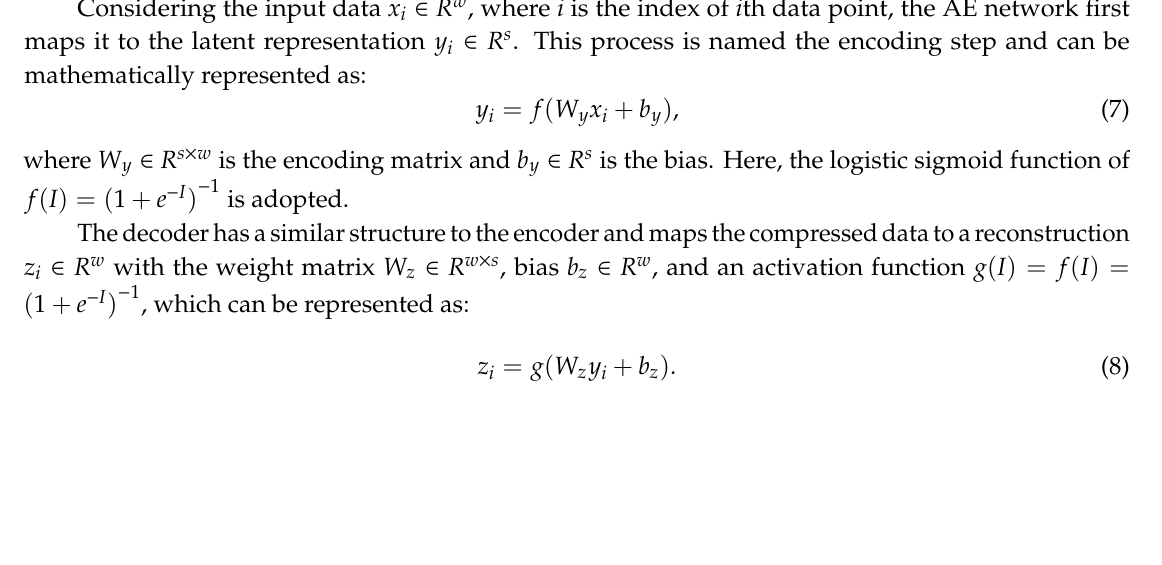
Figure 2. Single-layer auto-encoder (AE) network.